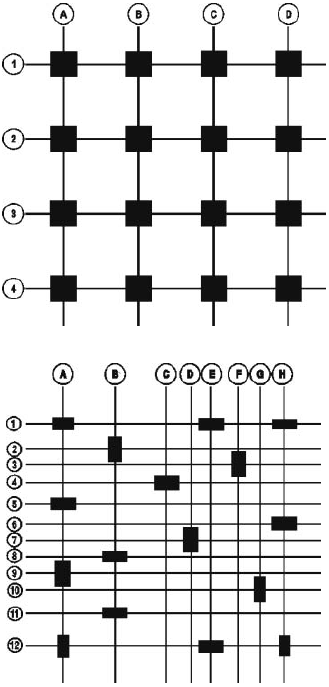
Fig. 1. Uniform and Symmetrical versus Scattered and Irregular